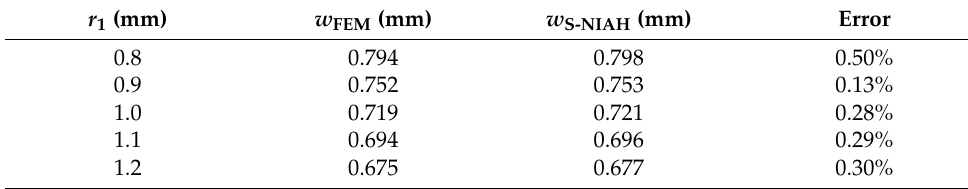
Table 5. Deflections and errors at mid-point under different r 1 .